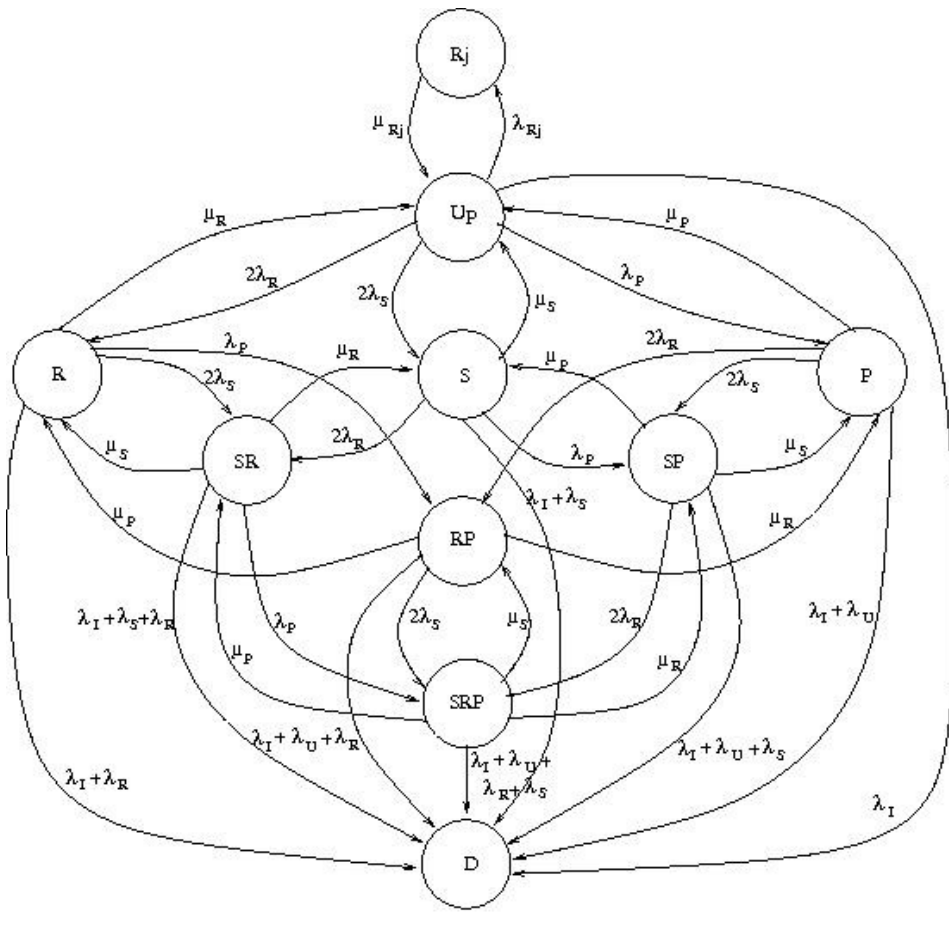
Fig. 1. Reliability model for a VoIP system with software